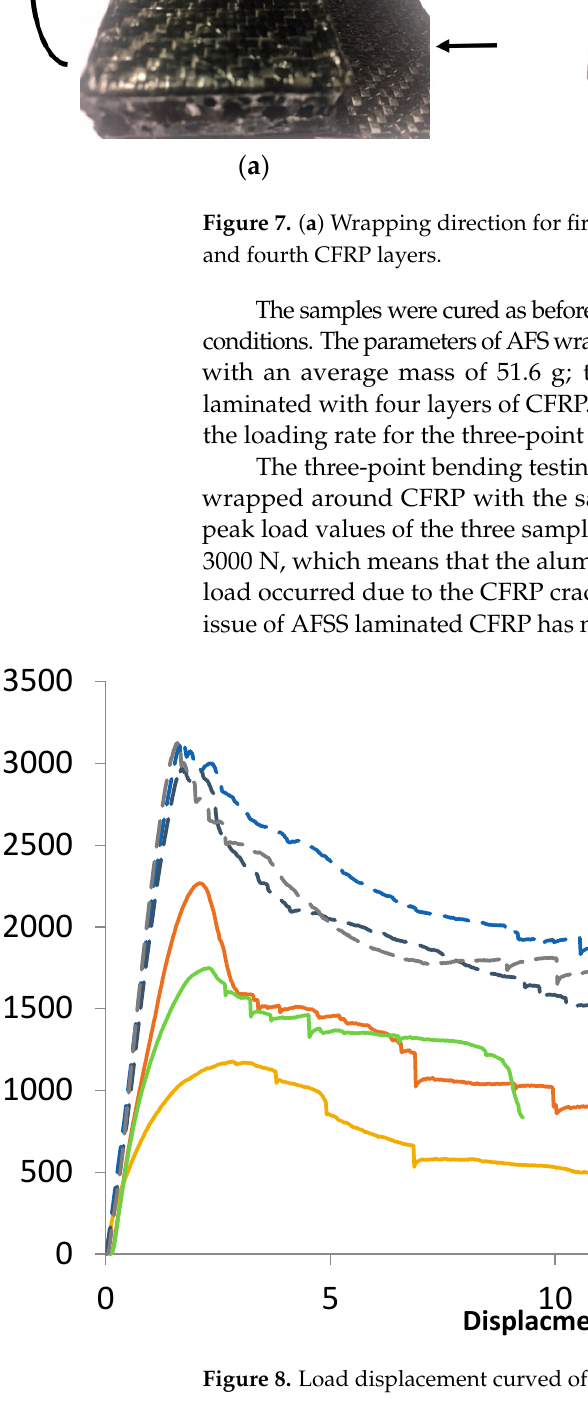
Figure 7. ( a ) Wrapping direction for first and third CFRP layers; ( b ) wrapping direction for second and fourth CFRP layers.